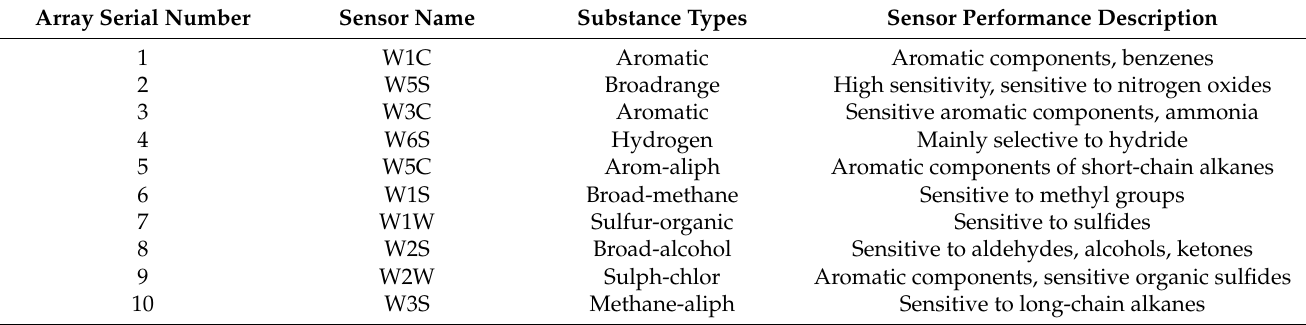
Table 2. Description of the types and properties of substances represented by the ten sensors of the